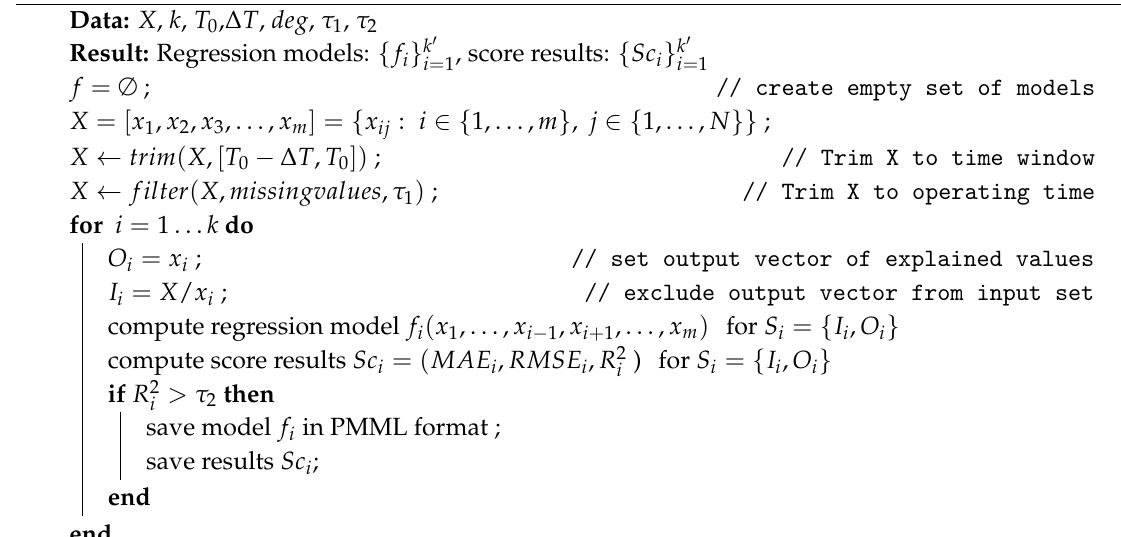
Algorithm 1: Computing the bag of regression